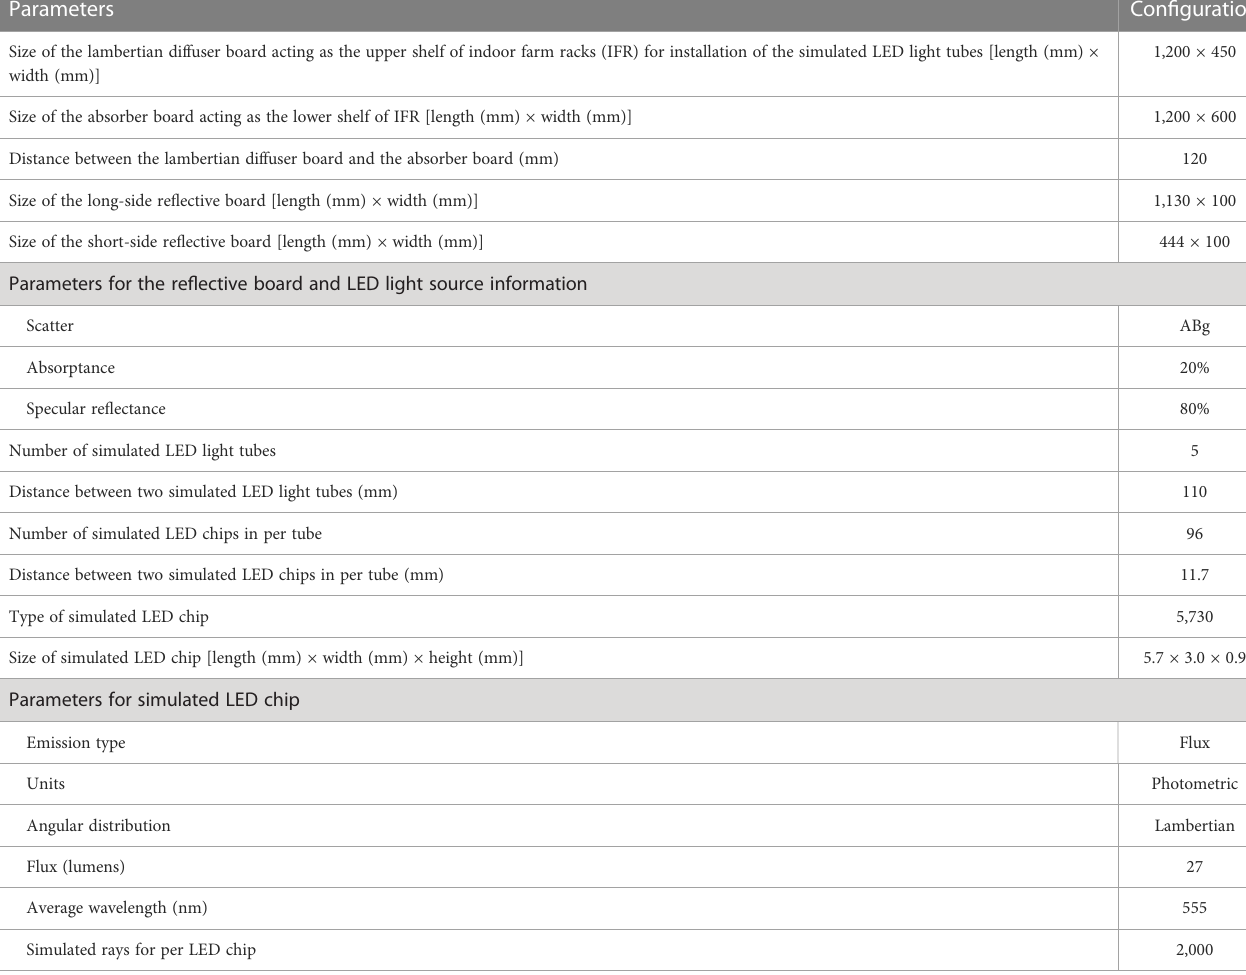
TABLE 1 Parameter con fi guration of TracePro software for the simulation of the novel adjustable lampshade-type re fl ector.